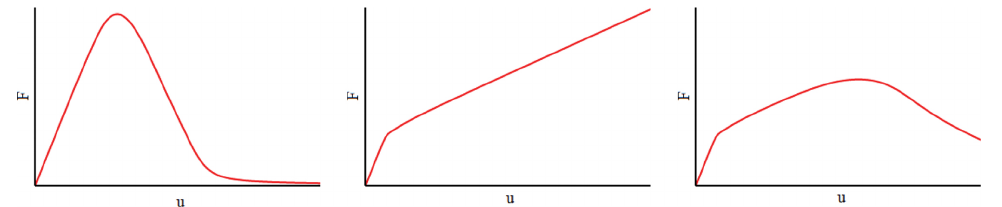
Figure 1: Schematic plot of a force vs. displacement diagram for damage (left), plasticity and isotropic hardening (center) and both